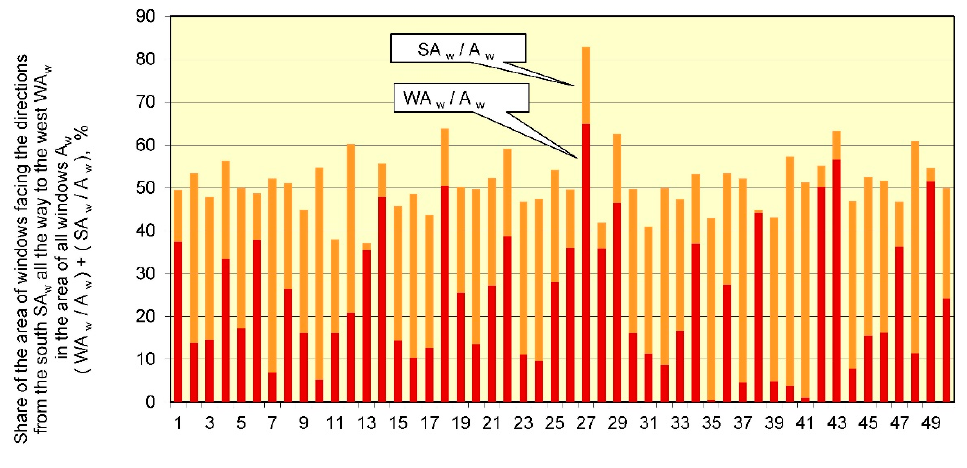
Figure 3. Share of the area of windows facing the directions from the south SA w all the way to the west WA w in the area of all windows A w in education buildings.